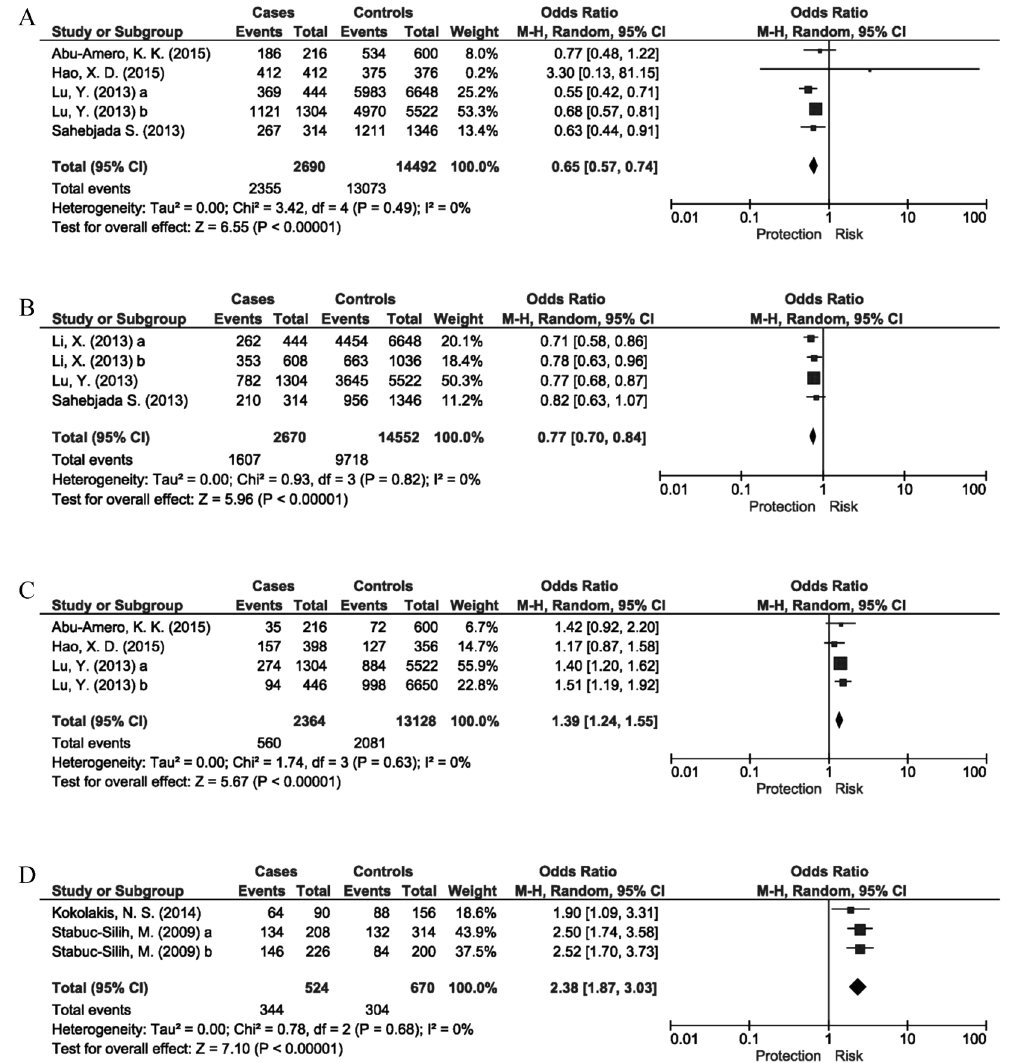
( B ) RXRA-COL5A1 (rs1536482, P = 2.5 × 10 − 9 , I 2 = 0) and ( C ) FNDC3B (rs4894535, P = 1.4 × 10 − 8 , I 2 = 0).